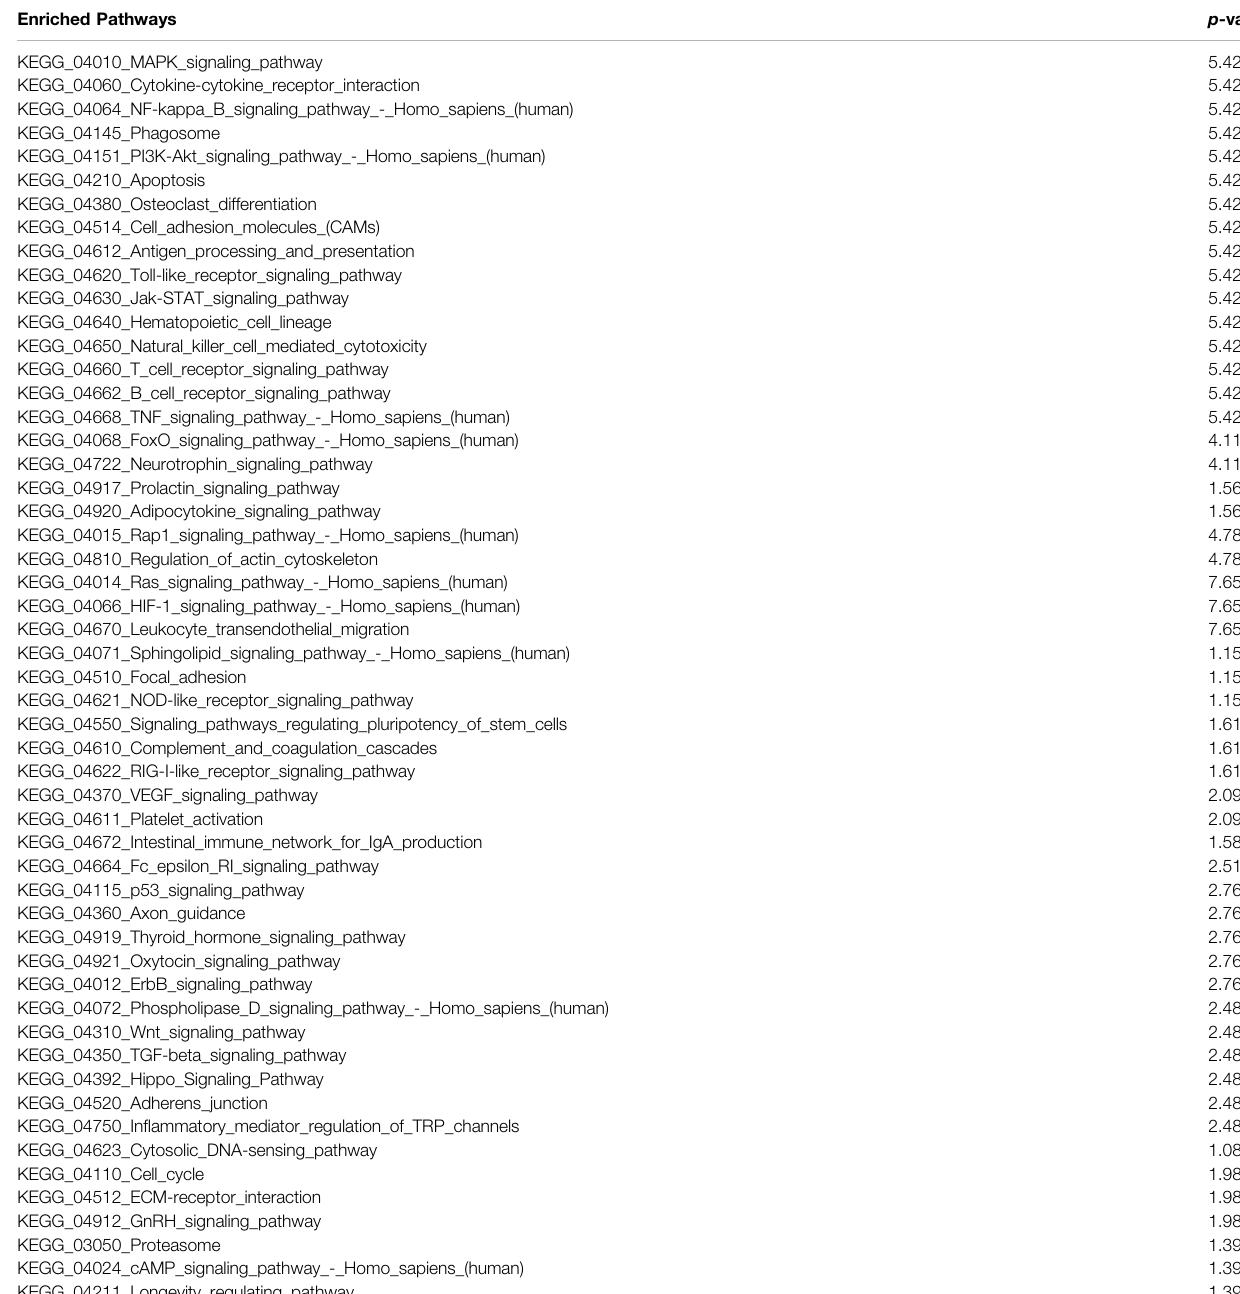
TABLE 1 | Enriched pathways for GSE183071 COVID-19 dataset